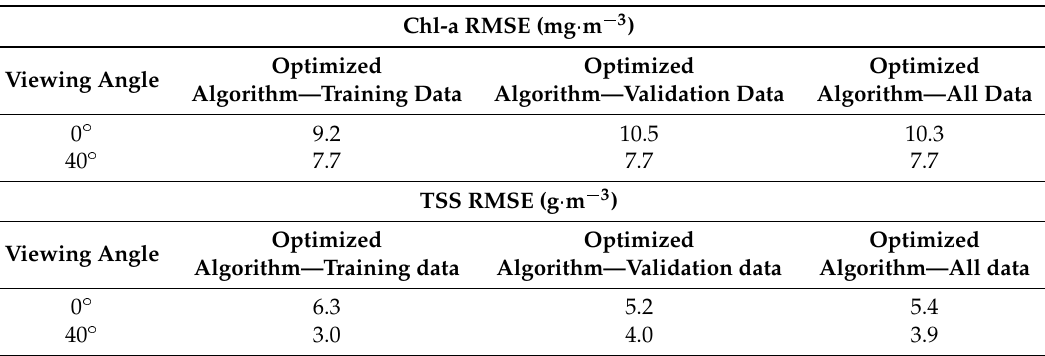
Figure 8. Results from the inversion of validation field spectrometer spectra. The dotted black line indicates 1:1 correspondence. n is the number of samples displayed. R 2 is the coefficient of determination calculated for each sub-plot data. Table 4. RMSE of constituent estimates for all runs.